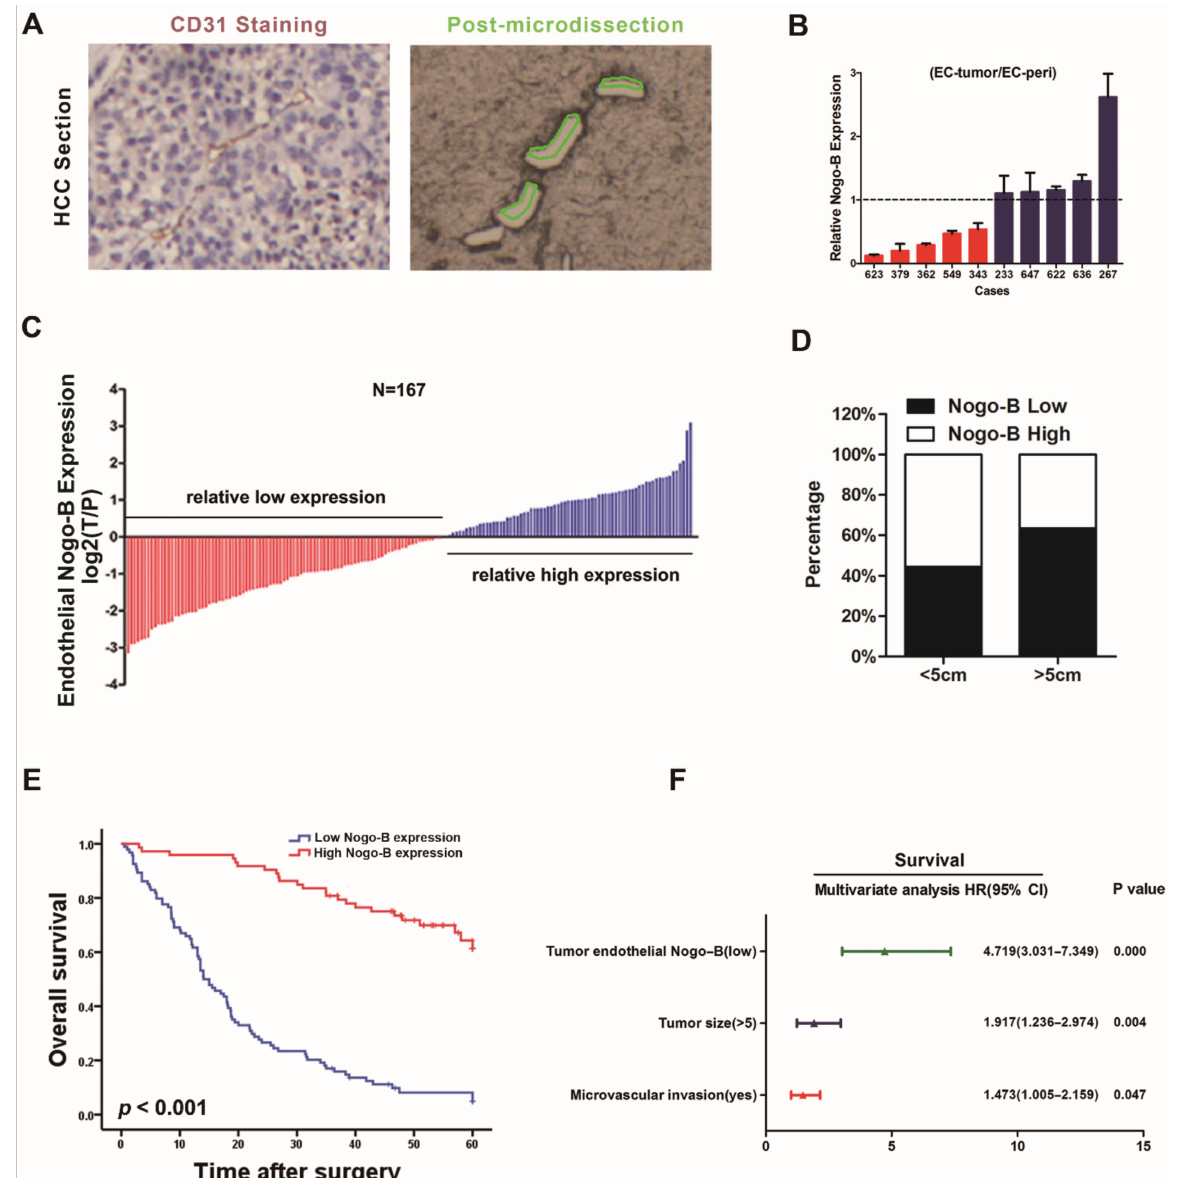
Figure 1. Reduced tumor endothelial Nogo-B expression predicts a poor prognosis for patients. ( A ) A representative image of laser capture microdissection of blood vessels. The left panel shows CD31-labeled blood vessels; the right panel shows the corresponding blood vessels in the consecutive sections that were dissected. ( B ) qRT-PCR assay of endothelial Nogo-B expression in the tumor and peri-tumor blood vessels obtained by laser capture microdissection from 10 patients with HCC. ( C ) Among 167 HCC specimens with paired peri-cancerous tissues, immunohistochemical staining detected lower endothelial Nogo-B expression in 94 cancer tissues (T) than in the corresponding peri-cancerous tissues (P), and higher endothelial Nogo-B expression was detected in 73 cancer tissues than in peri-cancerous tissues. ( D ) The proportion of low/high endothelial Nogo-B expression in patients with HCCs of sizes >5 cm/<5 cm. ( E ) Multivariate Cox regression analysis of 167 patients with HCC. p < 0.001. ( F ) The difference in patient survival between the high Nogo-B expression